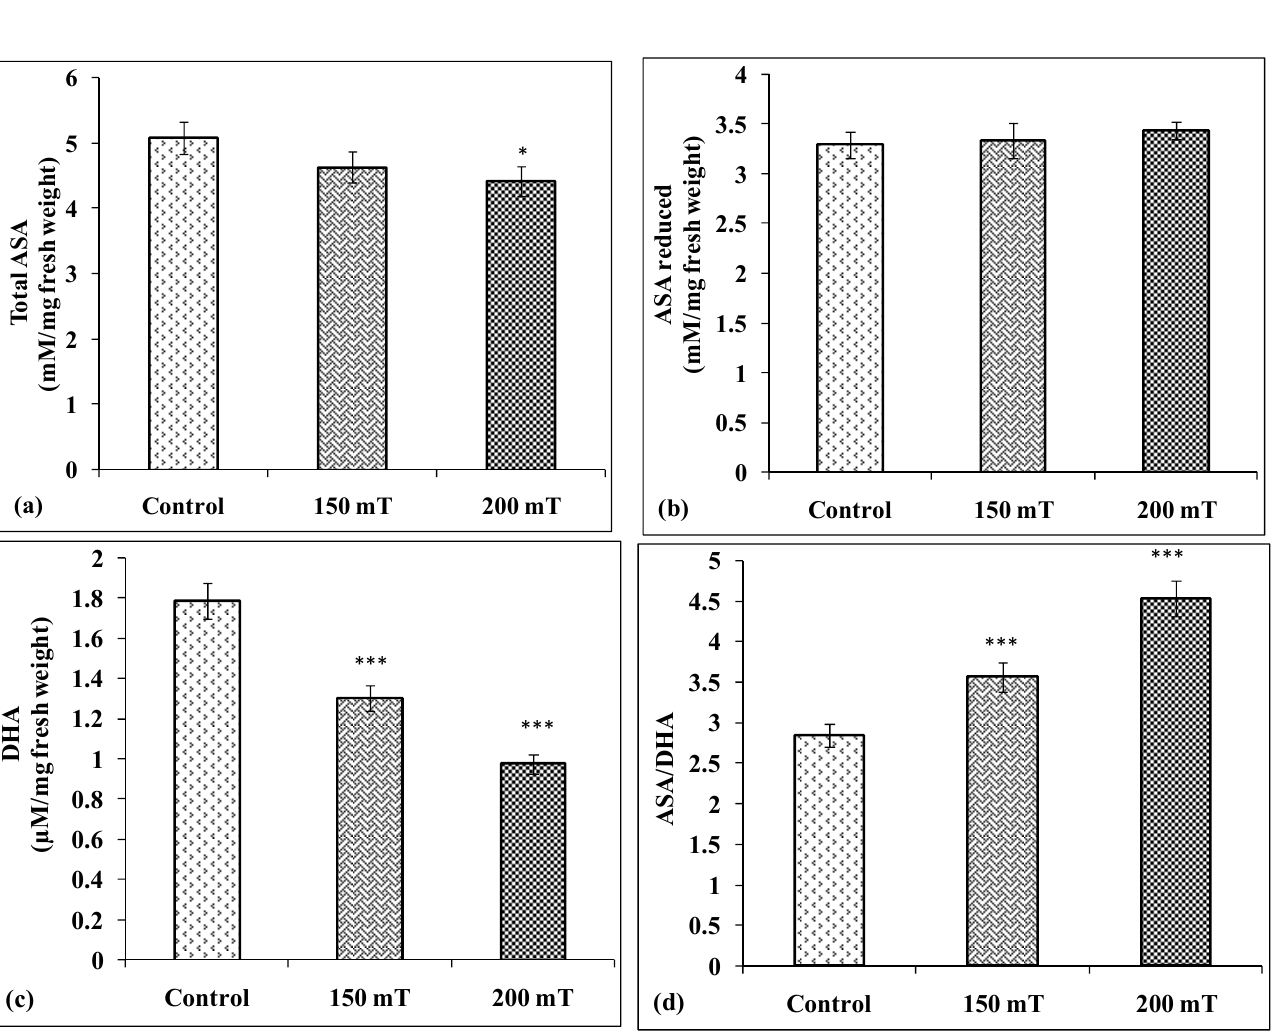
(d) Figure 12. Effect of pre-sowing magnetic field treatment of soybean seeds on antioxidant enzymes: Ascorbate (AA) peroxidase ( a ), guaiacol peroxidase ( b ), superoxide dismutase ( c ), and catalase ( d ). *** and ** indicate significance at p < 0.001 and0.01, respectively, compared to control. 3.3.3. Malondialdehyde (MDA) Malondialdehyde is a product of the peroxidation of tri-unsaturated lipids. When tri-unsaturated fatty acids with double bonds are three carbon atoms apart, linolenic [9,12,15-octadecatrienoic] acid peroxidises, and malondialdehyde is produced. A reduc- tion of 14% in malondialdehyde (MDA) production was found after both SMF treatments (150 and 200 mT) (Figure 13).